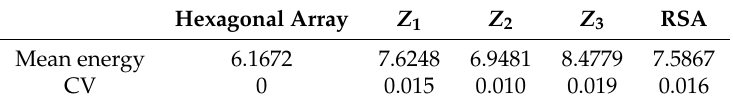
Table 1. The mean energy and the coefficient of variation (CV) of the energy